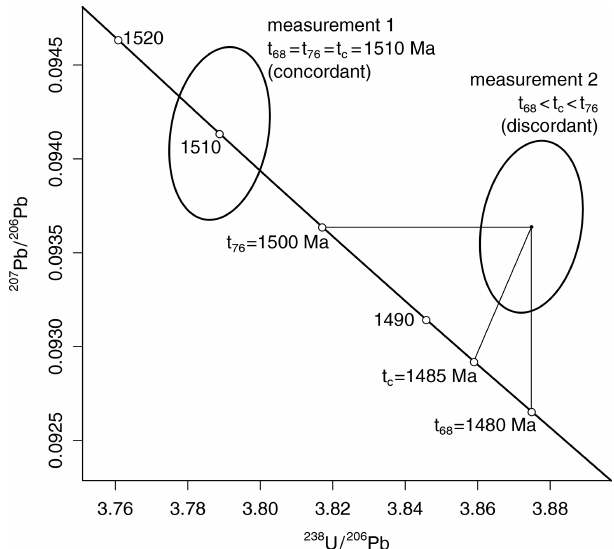
Figure 1. Illustrative Tera–Wasserburg concordia diagram with a concordant and discordant measurement. t 68 marks the 206 Pb / 238 U age, t 76 the 207 Pb / 206 Pb age, and t c the concordia age. Measure- ment 1 is concordant because its estimates for t 68 , t 76 , and t c are identical. Measurement 2 is discordant because the three estimates disagree. The concordia age is the most likely age given the analyt- ical uncertainties. It falls between the other two age estimates and offers the best analytical precision of the three.